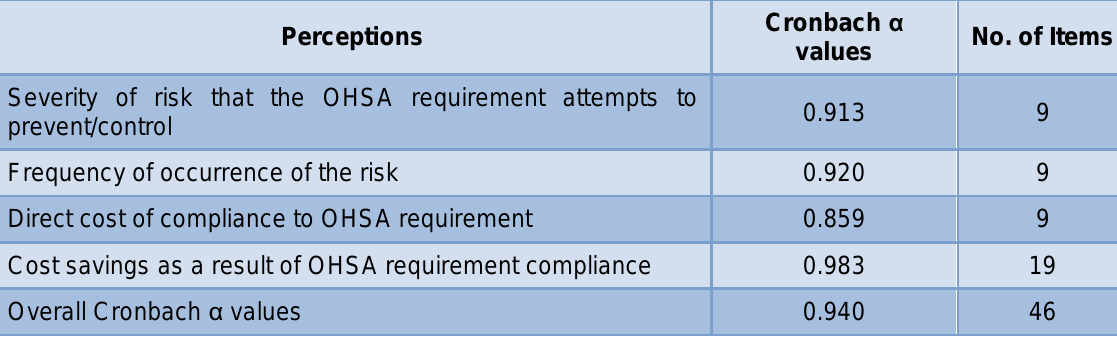
Table 2 Results of Test for Reliability (Cronbach’s α values) of Respondents’